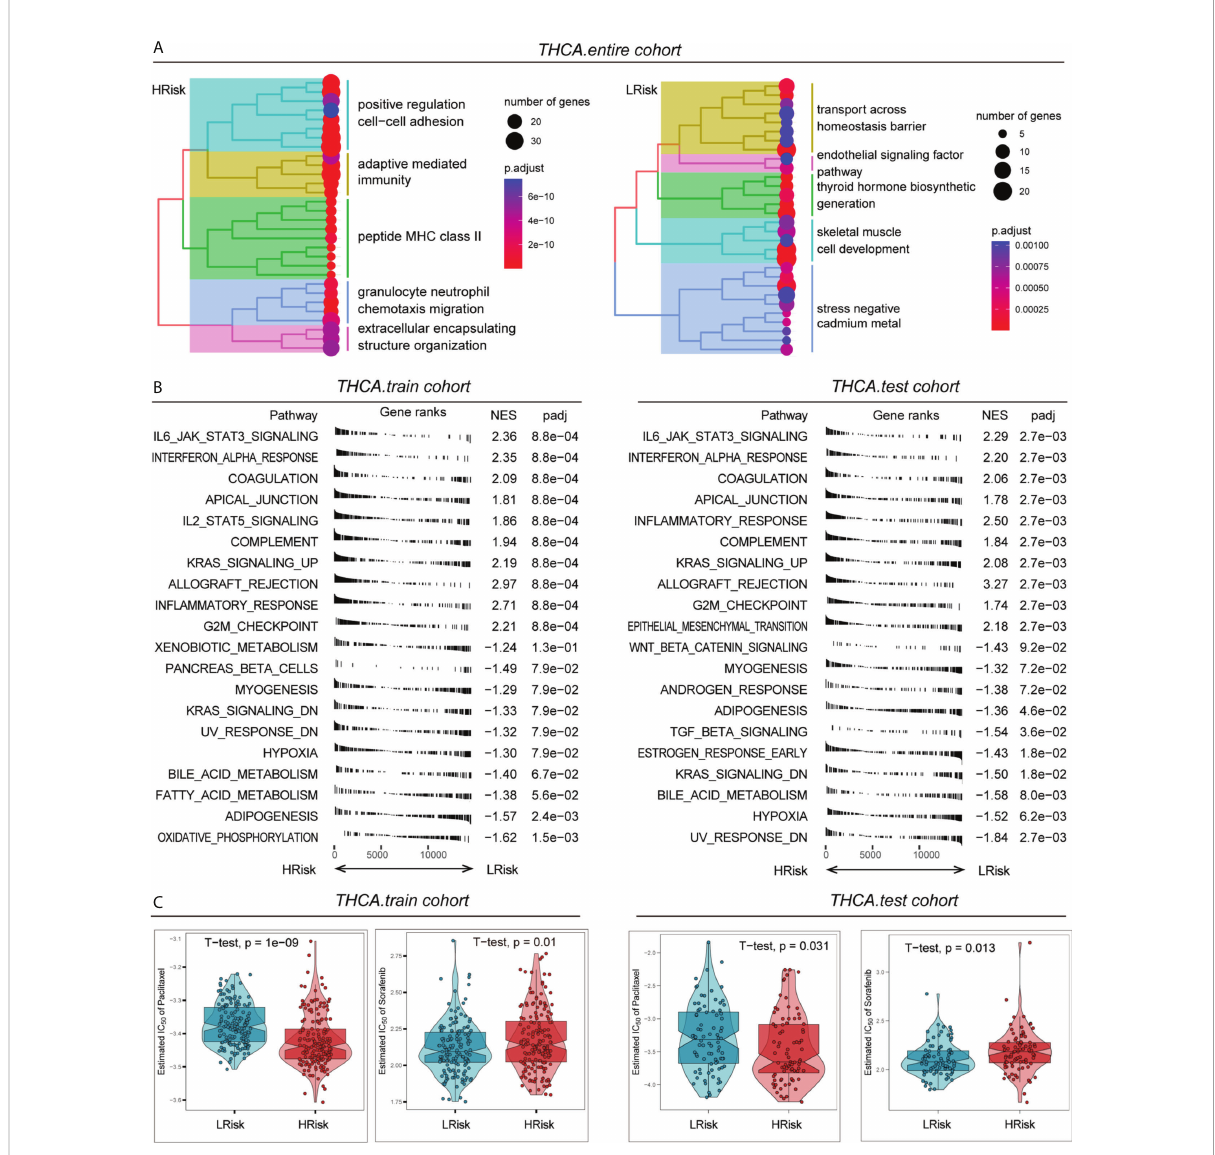
FIGURE 5 Pathway enrichment and drug sensitivity prediction of different risk groups. (A) Differences in the activation of different pathways of the HRisk and LRisk groups in the entire cohort. (B) Activation of different HALLMARK pathways in the HRisk and LRisk groups in the training cohort and test cohort. (C) Assessment of IC50 values for different drugs (paclitaxel or sorafenib) in the HRisk and LRisk groups in the training cohort and test